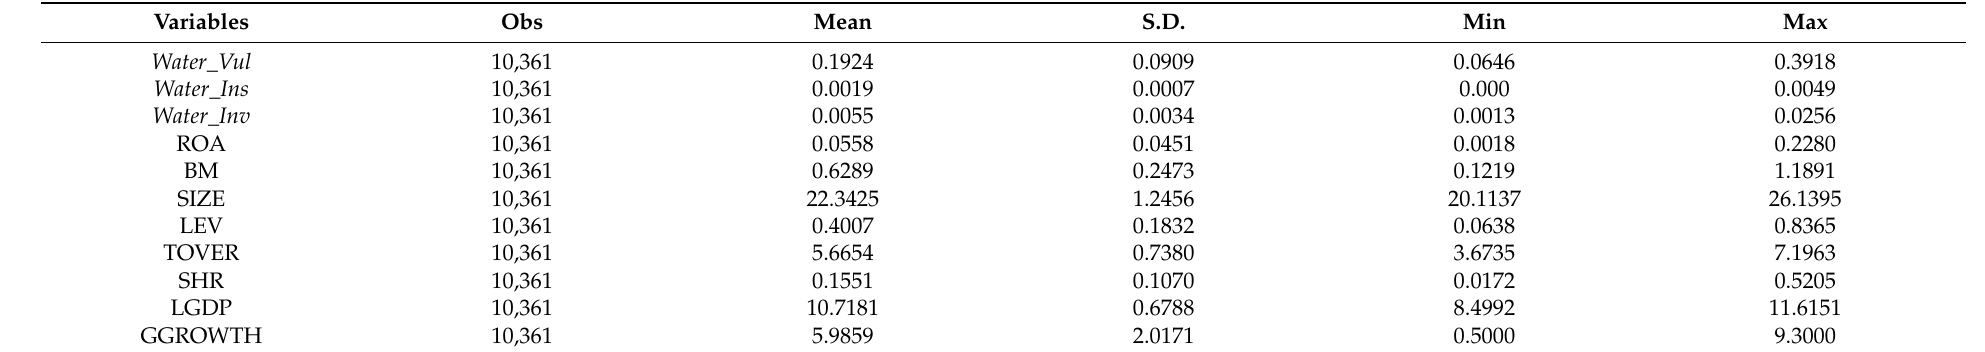
Table 3. Overall descriptive statistics.